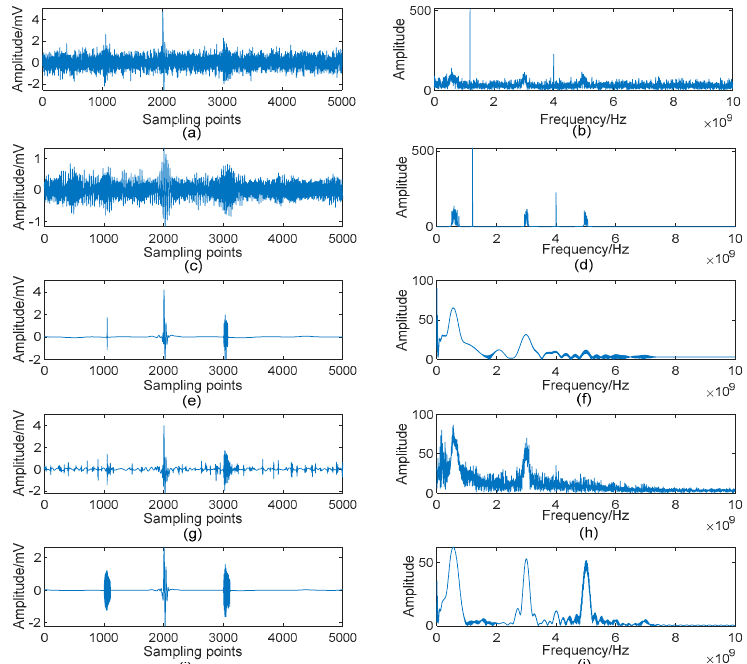
Figure 9. Denoising results by different algorithms: ( a ) Noisy signal; ( b ) Spectrum of the noisy signal; ( c ) Denoised signal by Method 1; ( d ) Spectrum of (c); ( e ) Denoised signal by Method 2; ( f ) Spectrum of ( e ); ( g ) Denoised signal by Method 3; ( h ) Spectrum of ( g ); ( i ) Denoised signal by Method 4; ( j ) Spectrum of ( i ).